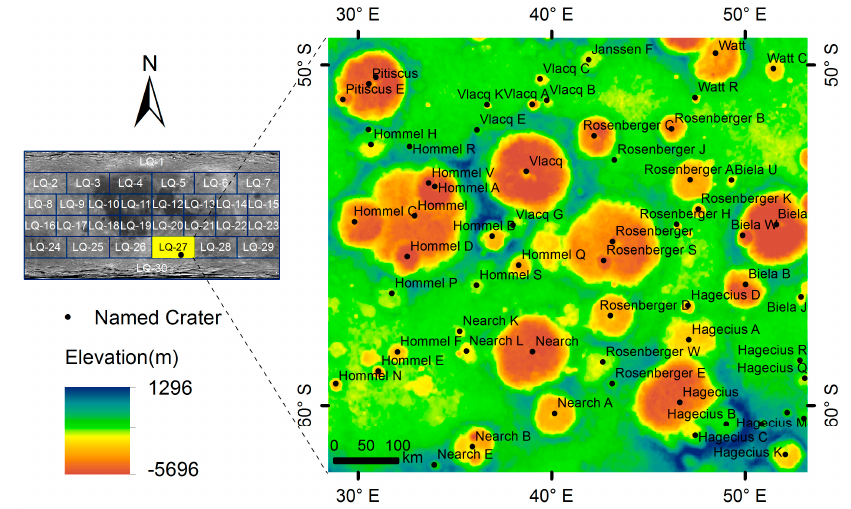
Figure 2. ( Left ) Localization of the study area. ( Right ) Chang’E Digital Elevation Model (DEM) of the study area. Also shown are craters named by the International Astronomical Union (IAU).